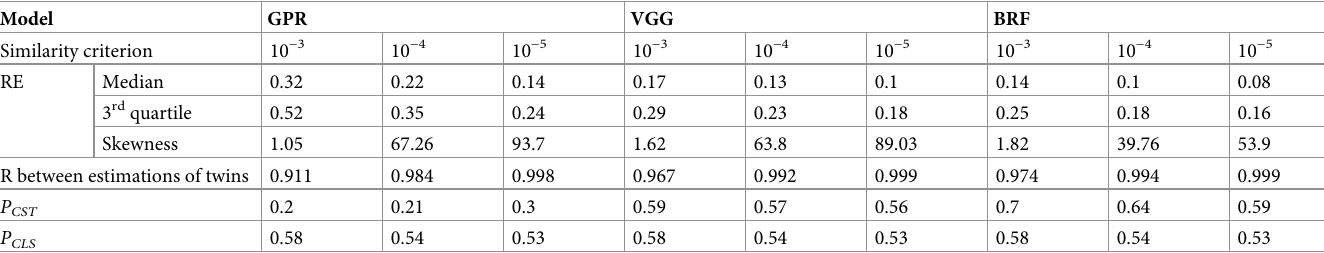
Table 4. Performance of models on spectral